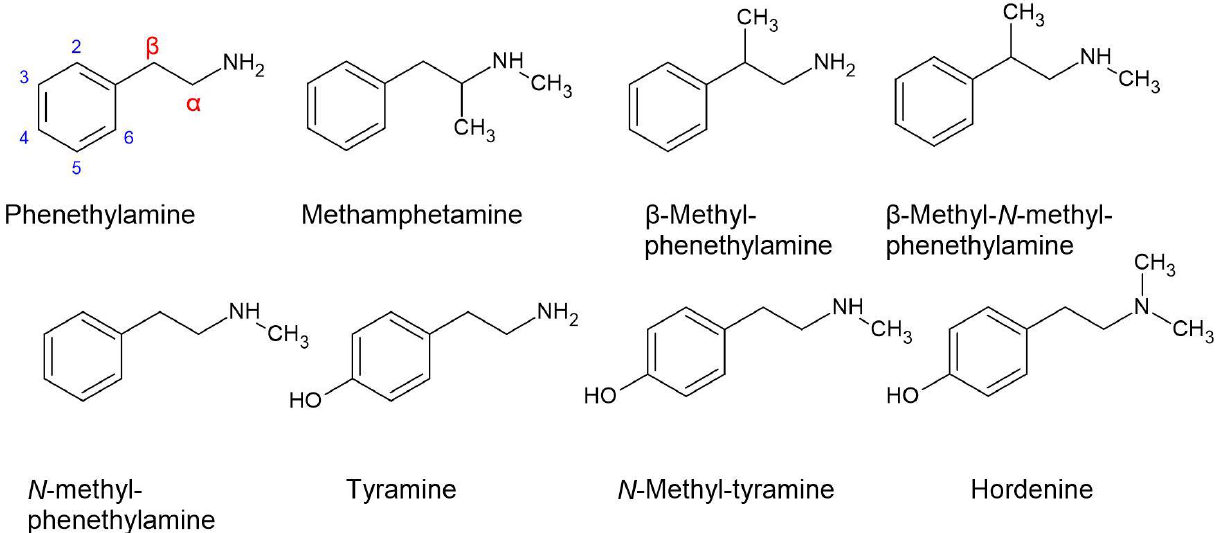
Figure 4. The phenethylamines (excluding methamphetamine) identified in species of Acacia and its sister genera.